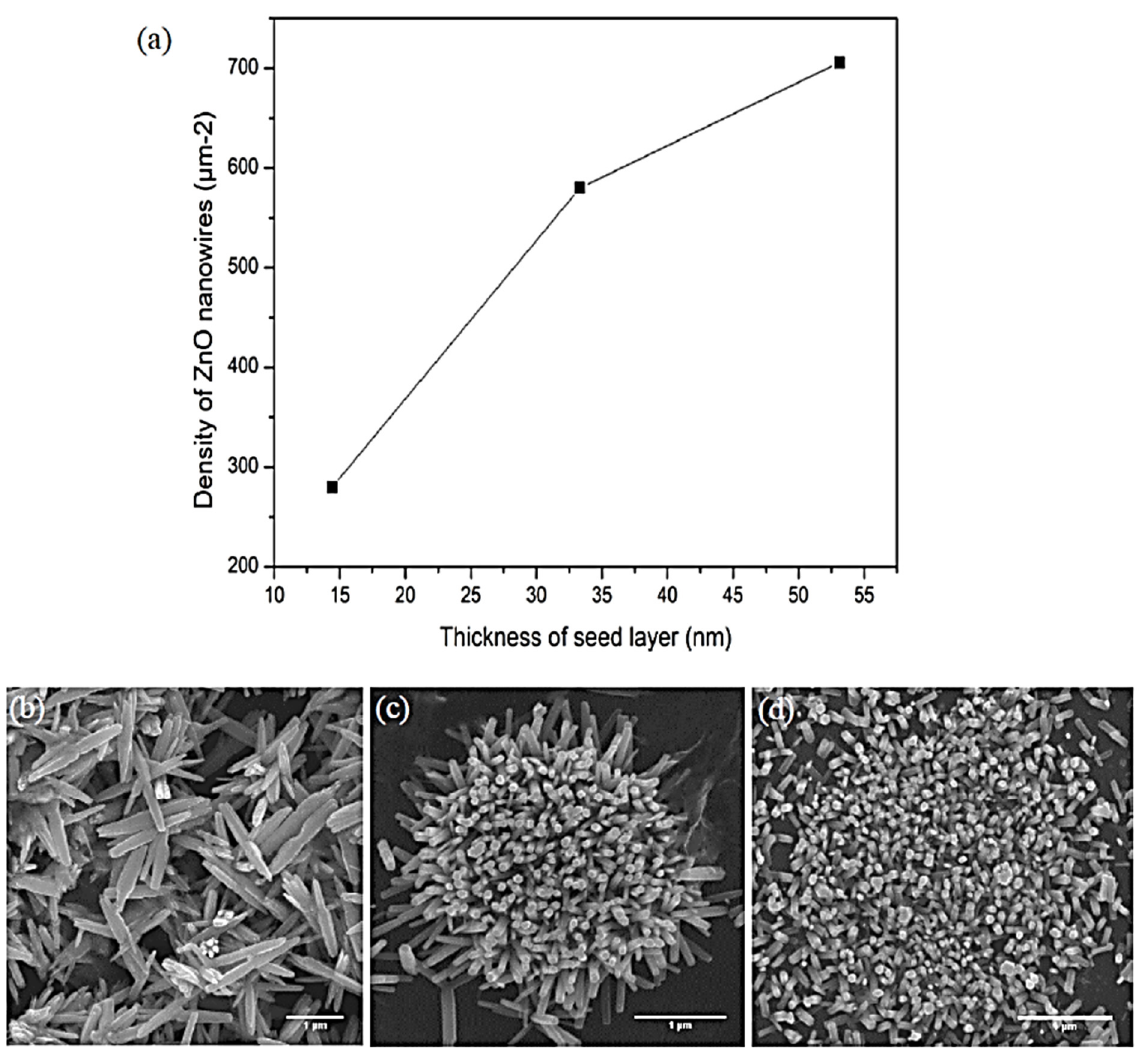
Figure 4. Graph of ( a ) density of ZnO nanowires with different seed layer thickness according to FESEM images of ( b ) one-layer sample, ( c ) three-layer sample, and ( d ) five-layer sample.